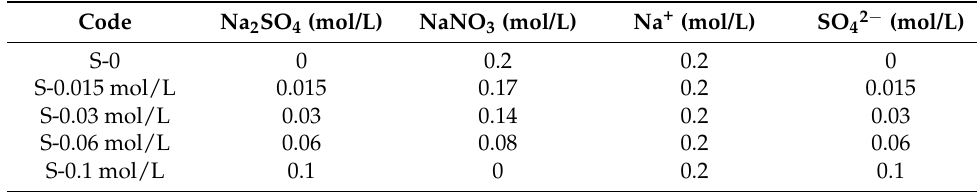
Table 1. The compositions of the simulated